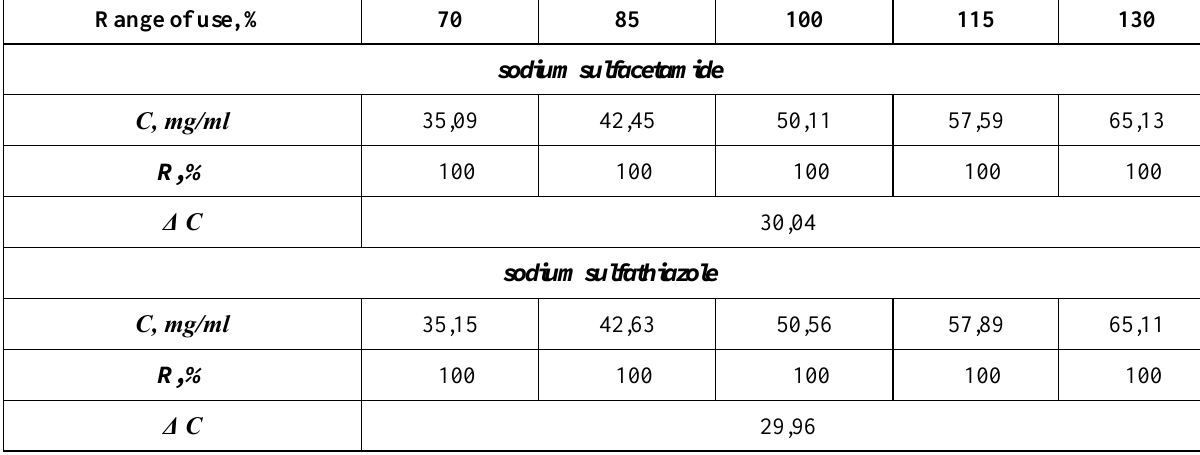
Data of the identification reaction results reproducibility of the derivatives of sulfanilic acid amides with the